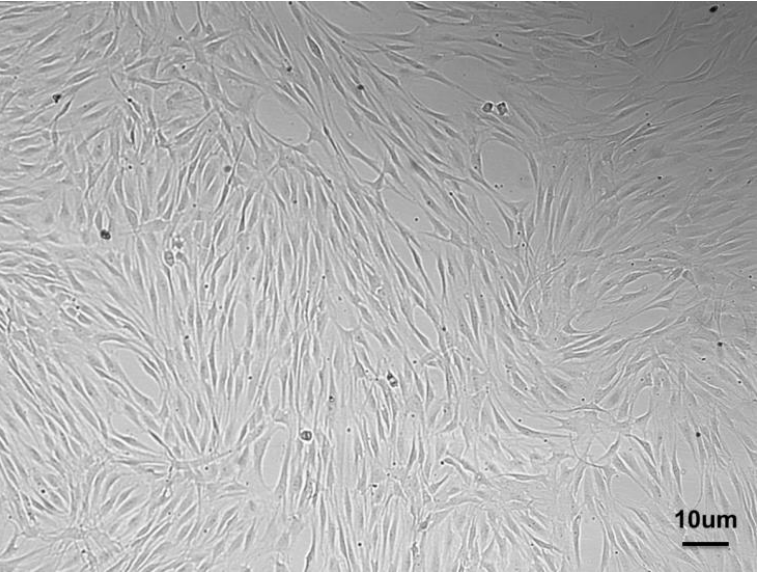
Figure 2. PDLSCs isolated from PDL and expanded in vitro showing the typical spindle shape. From this perspective, the role of the transforming growth factor– β 1 (TGF- β 1) sig- naling becomes interesting since its activation enables the commitment of cementocytes, while its inhibition promotes fibroblastic differentiation of the ligament progenitors